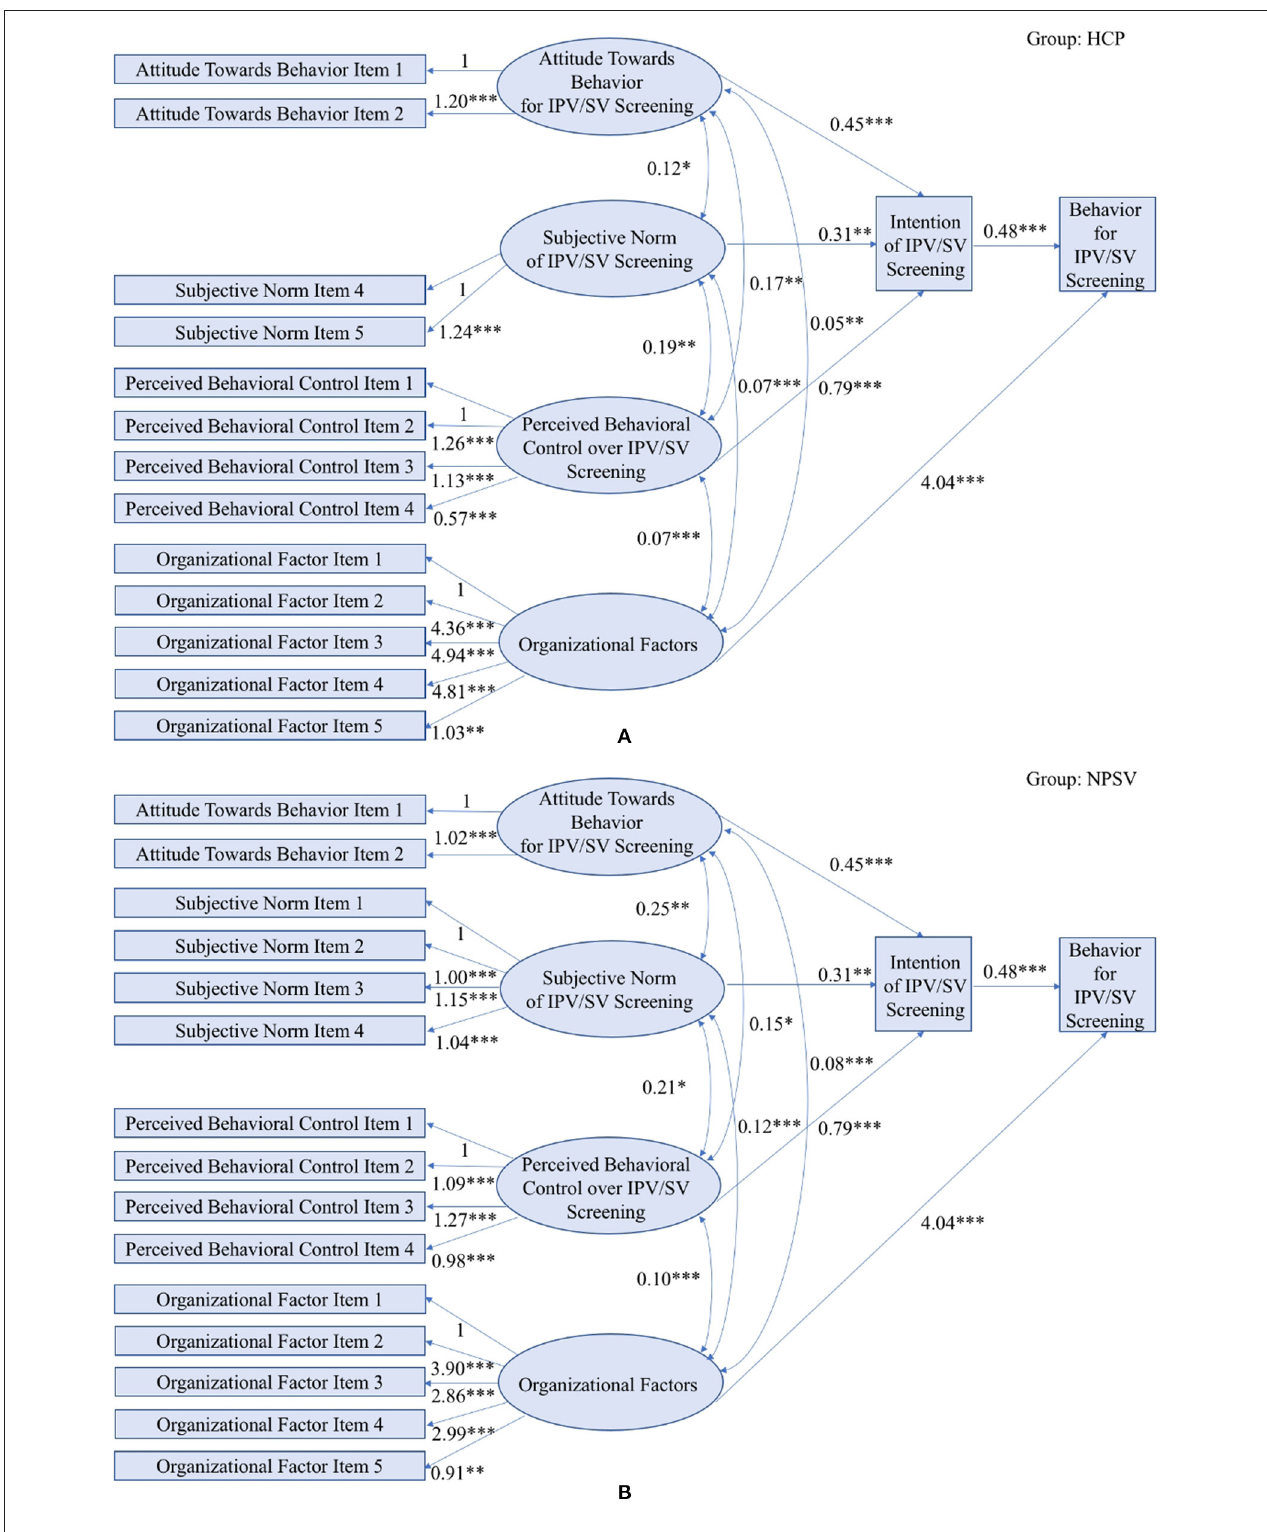
FIGURE 4 | Estimated SEM applied to Organizational Expansion of TPB in the HCP study (A) and the NPVS study (B) . (Model fit indices: LRT p -value < 0.001, CFI = 0.93, TLI = 0.92, RMSEA = 0.074; *** indicates p -value < 0.001, ** indicates p -value < 0.01, * indicates p -value < 0.05).